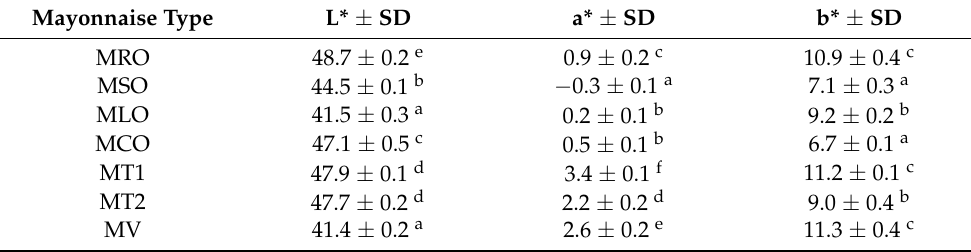
Table 6. Color of